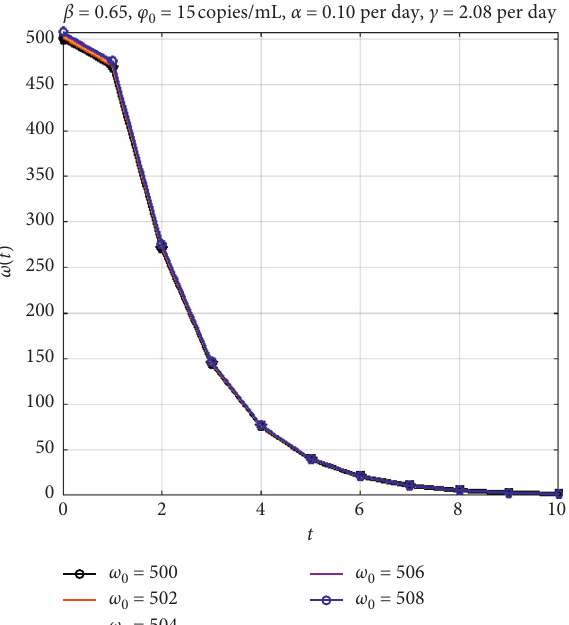
Figure 4: The number of infected cells ω for different values of time t and number of potentially infected cells at the beginning of therapy ω � 15 copies/mL , α � 0 . 10 day − 1 , and c � 2 . 08 day − 1 . with β � 0 . 65 day − 1 , φ 0